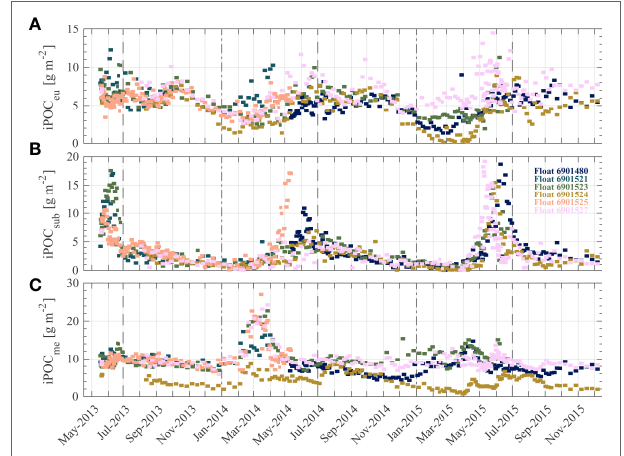
FIGURE 8 | Three parameters describing depth-integrated particulate organic carbon (POC) for six BGC-Argo floats sampling in the Labrador Sea region detailed in Figure 7A . Parameters refer to POC integrated within (A) euphotic and (B) sub-euphotic layers of epipelagic zone, and (C) mesopelagic zone. See text for more details regarding calculation of depth-integrated POC parameters.